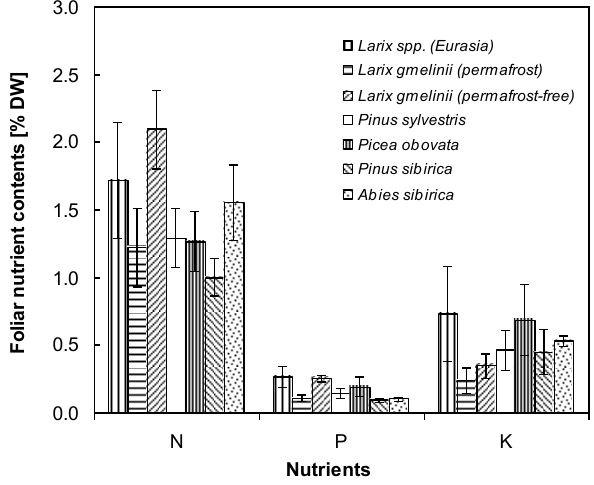
Figure 6. Mass-based concentrations of macronutrients in the foliage of main conifers of Siberia during the mid-growing season [13] compared with L. gmelinii collected at permafrost-affected and permafrost-free sites in this study.